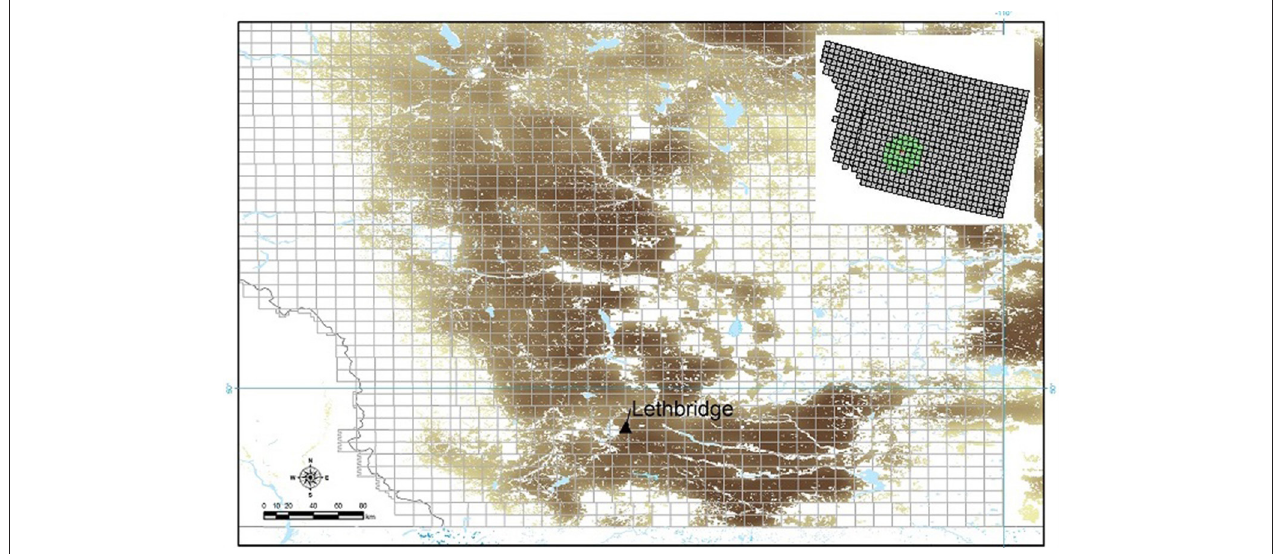
FIGURE 2 | The southern Alberta, Canada region of interest (ROI): The Lethbridge site (located within township TW008R21W4) is indicated; areas where wheat (winter, spring) are grown are indicated (brown) superimposed on a grid of Alberta townships ( ∼ 10km). A sub-region of 40 municipalities was selected surrounding the Lethbridge site for model computations (upper